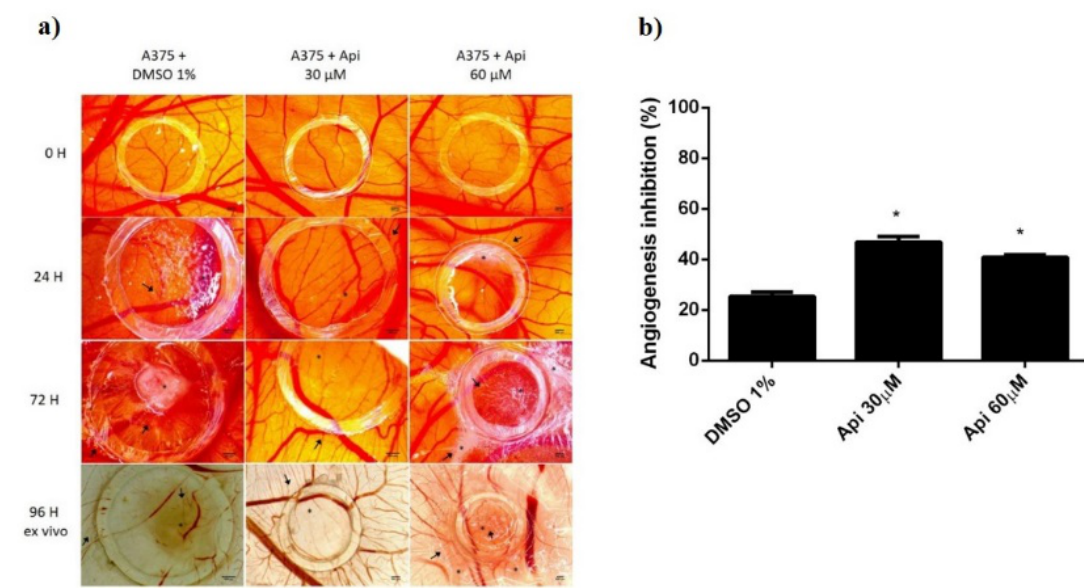
Figure 12. A375 melanoma cells on CAMs treated with Api: ( a ) Stereomicroscopic in vivo images of the areas previously inoculated with melanoma cells and treated with Api 30 and 60 μ M and with DMSO 1% as solvent control; initially—0 h, after 24 h, after 72 h, and after 96 h, ex vivo, after membranes biopsies were obtained; ( b ) the angiogenic inhibition % in A375 melanoma cells environment, at 48h, for Api 30 μ M and 60 μ M compared to DMSO 1%. * p <